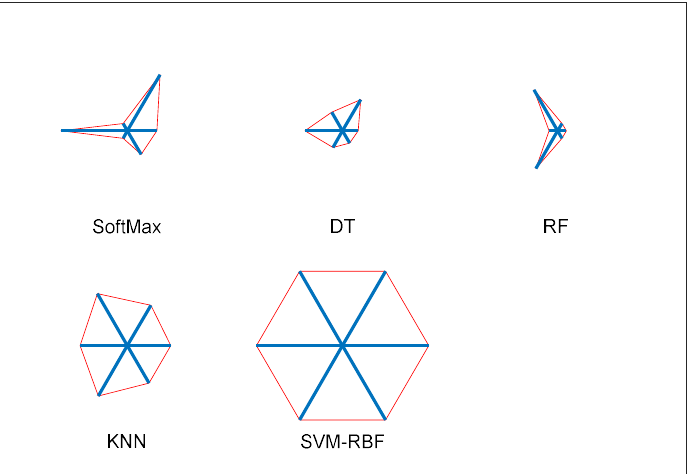
Figure 11. Overall performance of VGG19 with various classifiers summarized as glyph-plots.